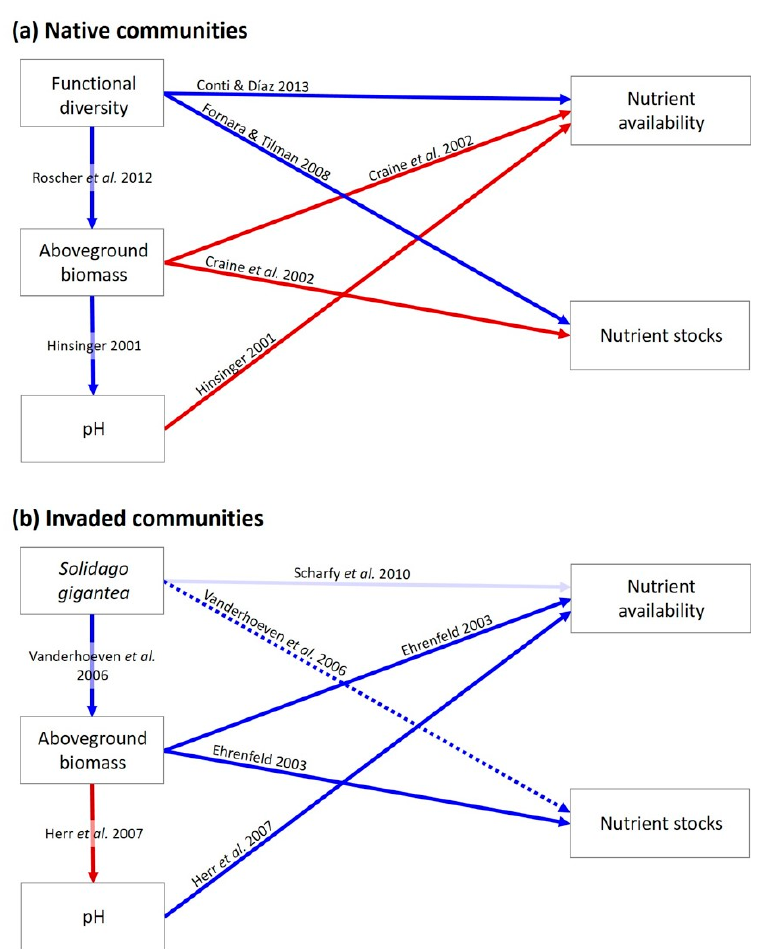
Figure 1. Hypothesised causal relationships of functional diversity of native plants, the invasive alien Solidago gigantea , plant aboveground biomass and soil pH with soil nutrient availability and stocks for ( a ) uninvaded [3–5,9,24] and ( b ) invaded communities [19,26,29,30]. Arrows represent unidirectional relationships among variables, blue arrows show positive and red arrows show negative relationships. Solid lines indicate significant paths ( p ≤ 0.05), and dashed lines indicate marginally significant paths ( p ≤ 0.10), while transparent arrows represent non-significant paths ( p > 0.10).